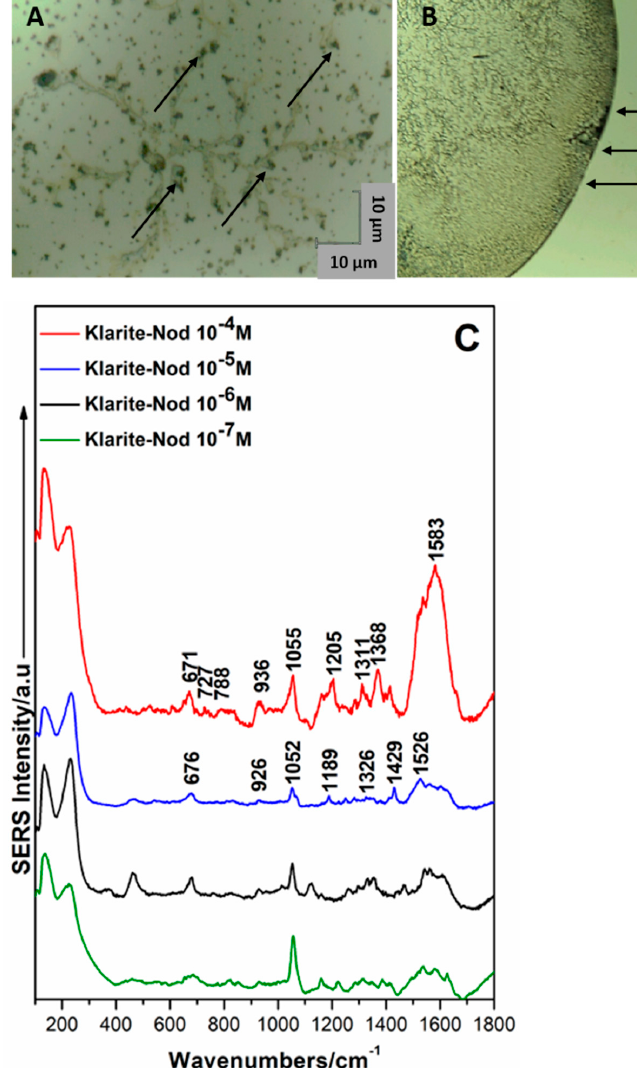
Figure 4. Optical images showing the samples for NOD on Klarite TM substrate by using 100 × ( A ) and 20 × ( B ) magnification. Arrows show selected points for laser irradiation. SERS spectra recorded on Klarite TM substrate for NOD in ethanol at different concentration using 532 nm laser line ( C ). SERS marker bands of NOD are present in the spectra recorded using the Klarite TM substrate at 1205 cm − 1 , 1311 cm − 1 , 1368 cm − 1 , 1583 cm − 1 and 1656 cm − 1 , respectively. A me- dium- to strong-intensity SERS band is present at all concentrations tested at 1055 cm − 1 .